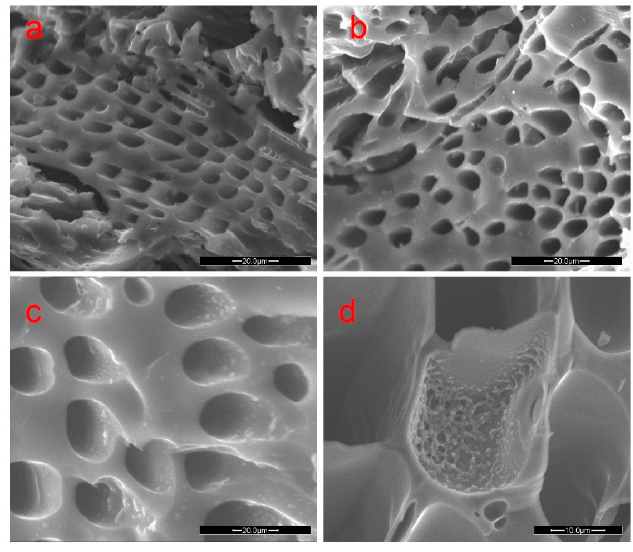
Figure 3. SEM images of different wood/resin ratios at 1000 °C. ( a ) 60 (wood):40 (resin); ( b ) 50 (wood):50 (resin); ( c ) 40 (wood):60 (resin); and ( d ) glassy carbon left by carbonization PF in void.